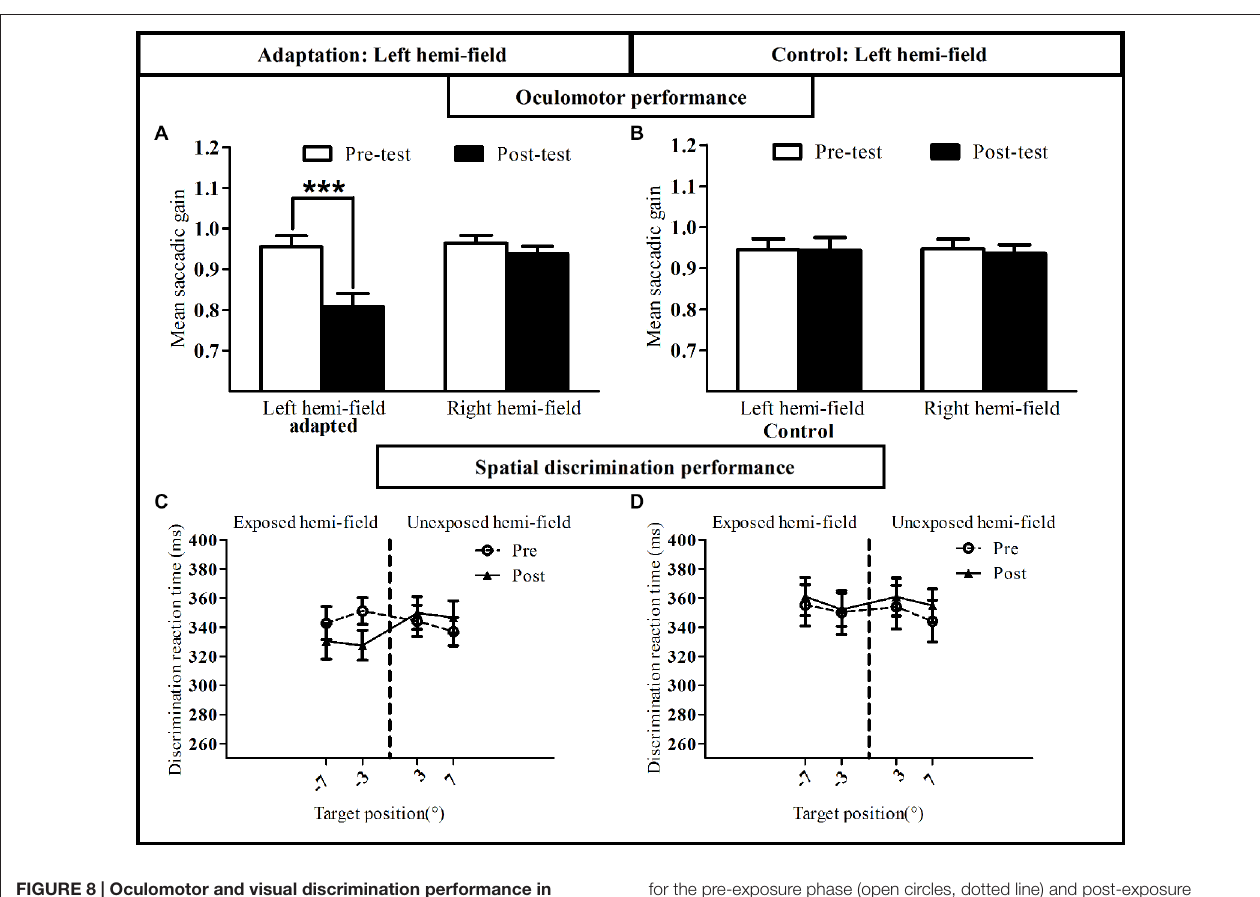
FIGURE 8 | Oculomotor and visual discrimination performance in Experiment II. Upper row: mean saccadic gain is shown in the pre-(white bars) and post-exposure phases (black bars) in the reactive saccade adaptation session (A) and in the control session (B). Lower row: mean manual reaction time is plotted as a function of target position